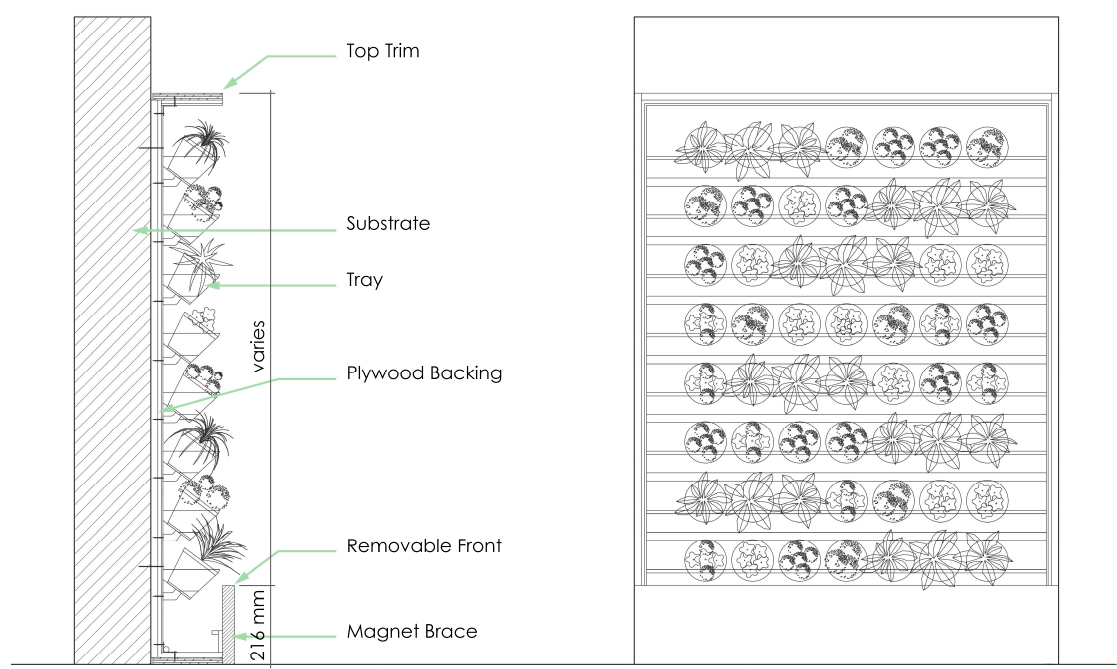
Figure 6. Living wall concept based on